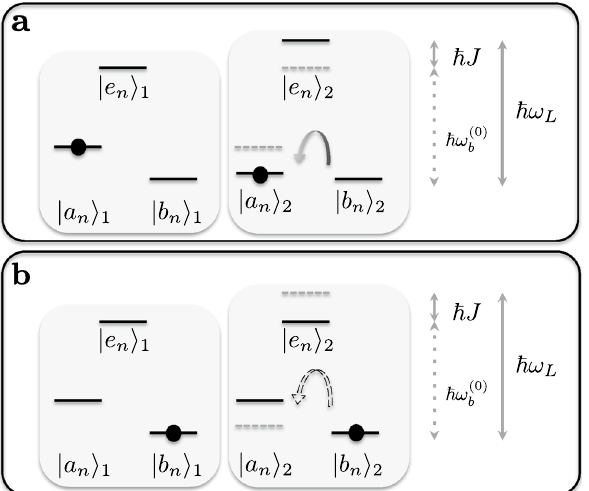
a n 1 (black dot) induces an energy | � b n a n 2 2 (full curved arrow). ( b ) A | � → | �